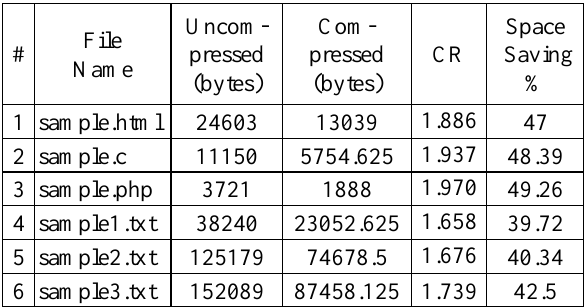
Table 4. Improvised GZIP for Real time